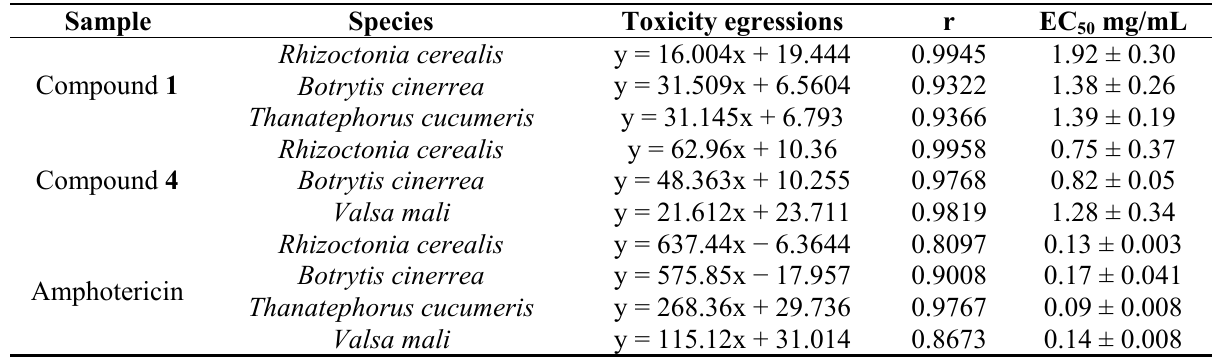
Table 2. Antifungal results of compounds 1 and 4